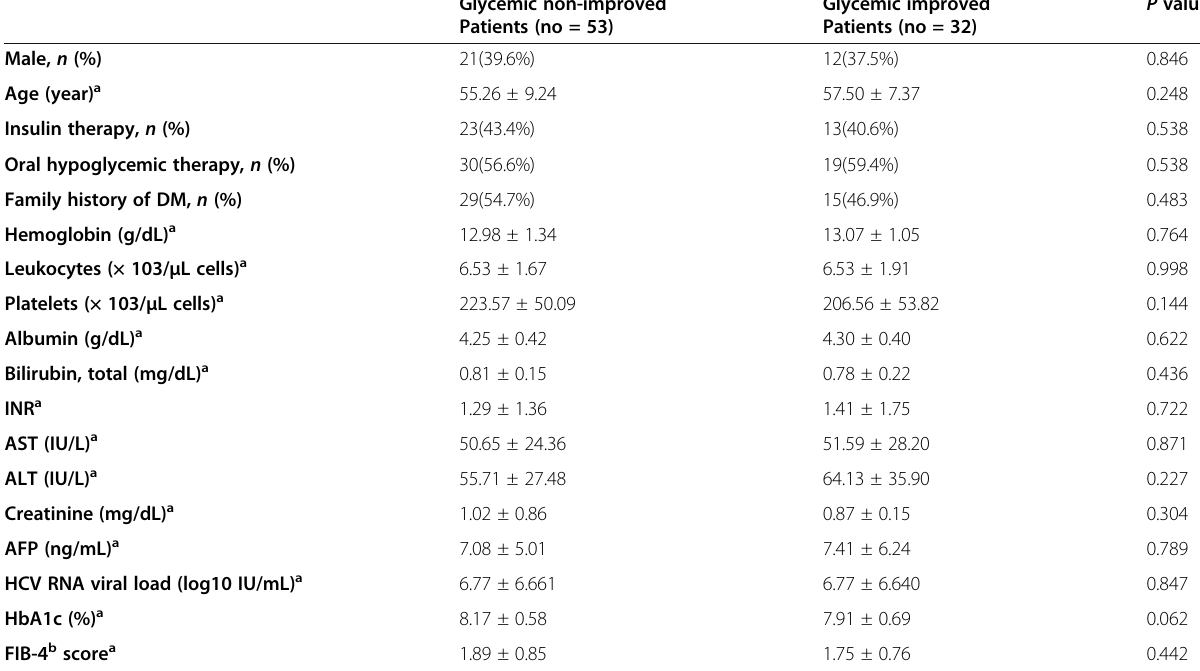
Table 1 Baseline demographic and clinical characteristics of all included